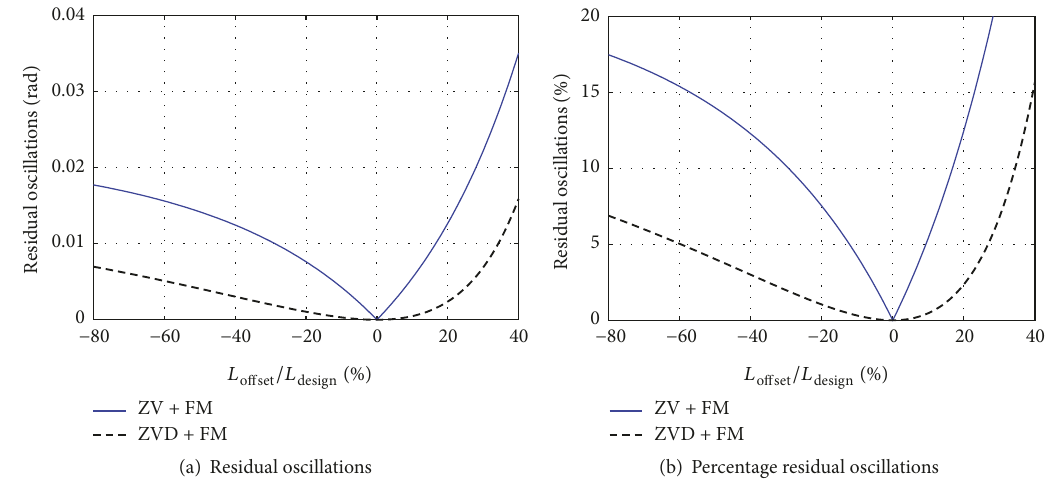
Figure 12: Simultaneous travel and hoisting maneuver using FM shaped